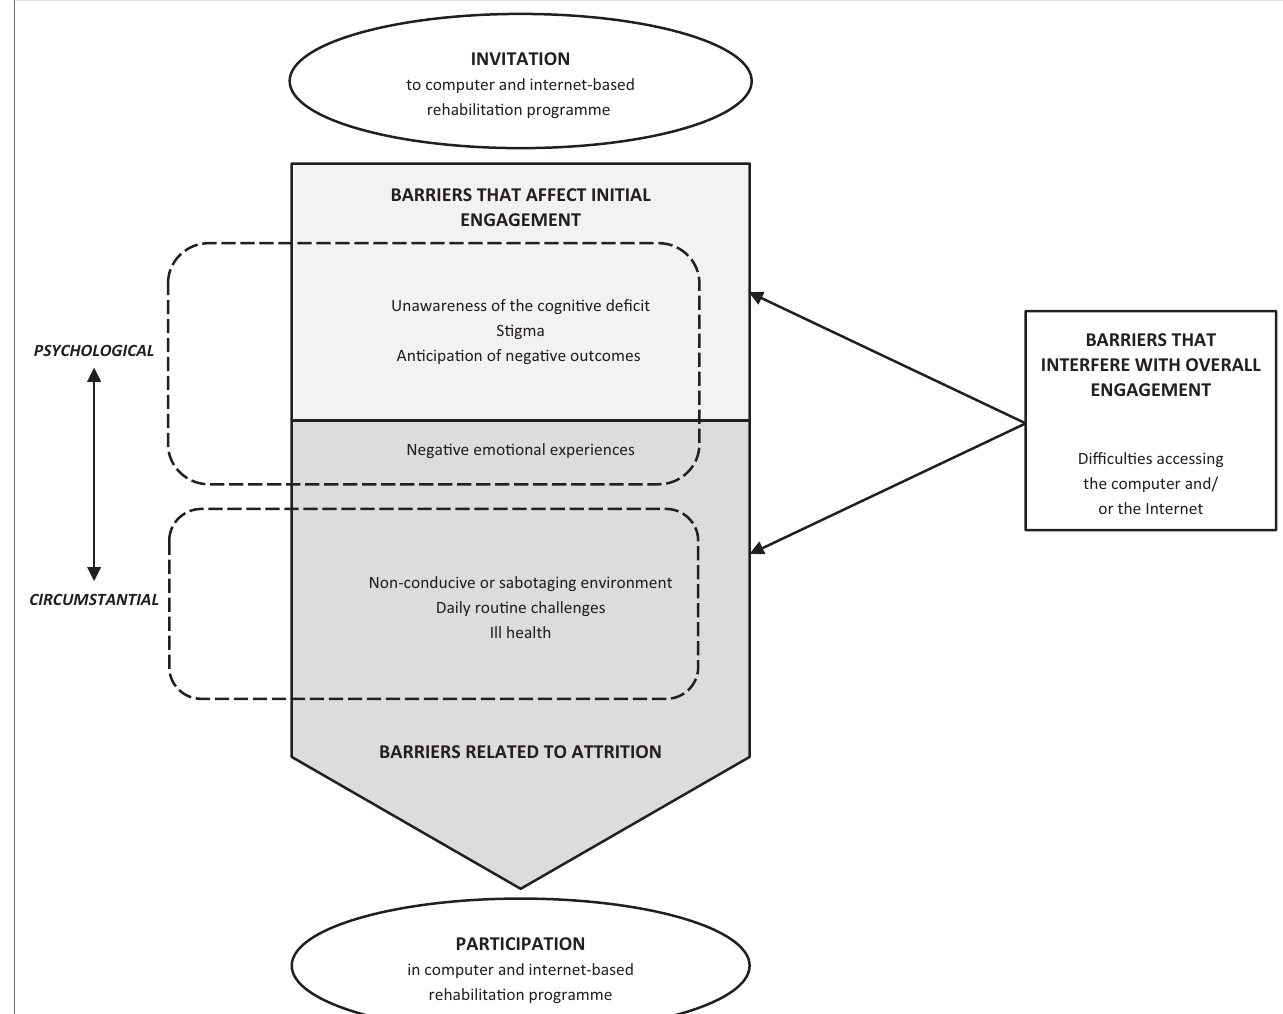
FIGURE 1: Representational model of the barriers to the implementation of an Internet-based rehabilitation program in a public healthcare